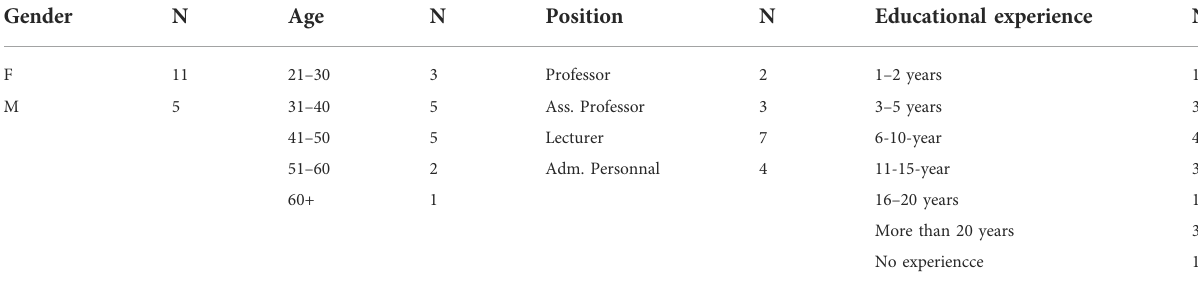
TABLE 1 The sample demographics (gender, age, position, educational experience).